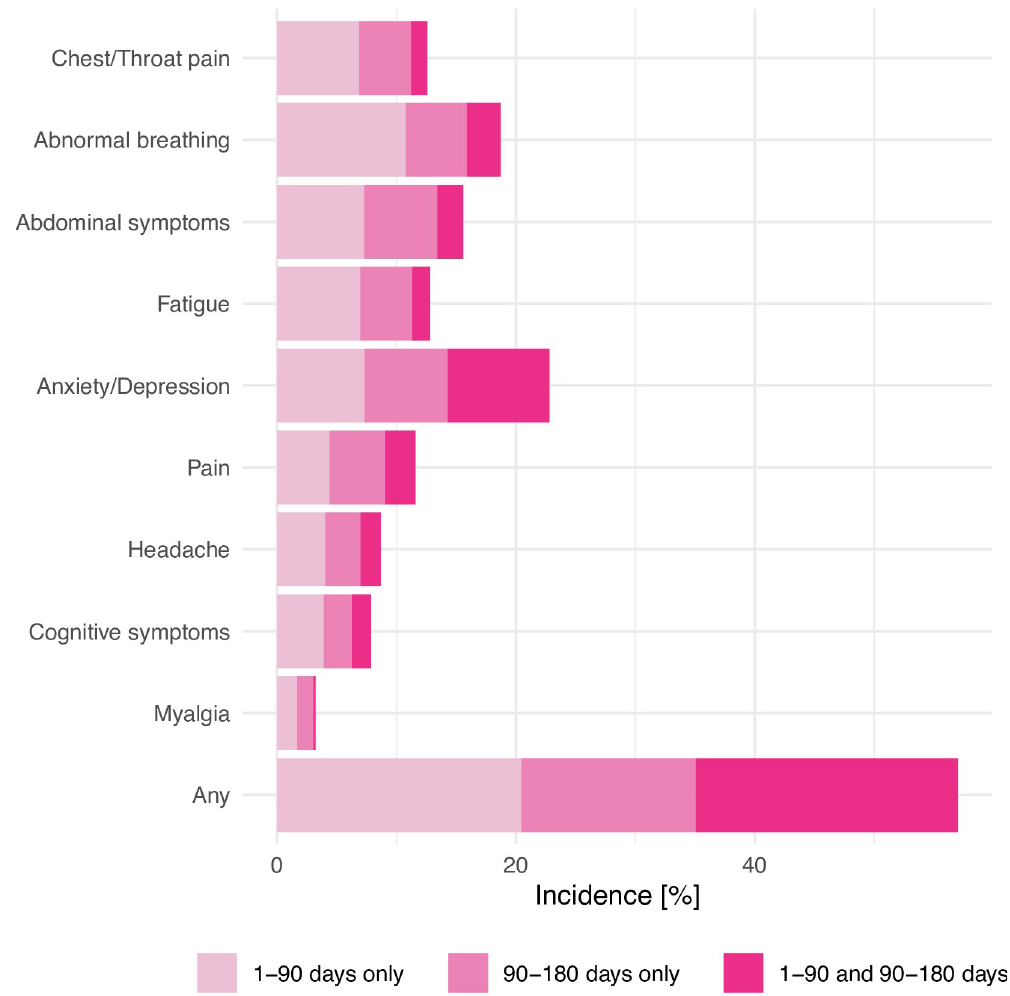
Fig 1. Incidence of each long-COVID feature in the 180 days after COVID-19. The total length of the bars represents the incidence over the entire 1–180-day period. The contributions to this overall incidence are provided in terms of incidence of features that occurred in the 1–90-day period only (i.e., those that did not recur in the 90–180-day period), incidence of features that occurred in the 90–180 days only (i.e., those that had not already occurred in the 1–90-day period), and incidence of features that occurred in the 1–90-day period and recurred in the 90–180-day period. As can be seen by comparing the 2 darker shades of the bottom bar, 60.1% of patients with a feature recorded for the first time in the 90–180 days after diagnosis had at least one feature recorded in the first 90 days. COVID AU : AbbreviationlistshavebeencompiledforthoseusedinFigs 1 (cid:0) 3 and 5 : Pleaseverifythatallentriesarecorrect : -19, Coronavirus Disease 2019.